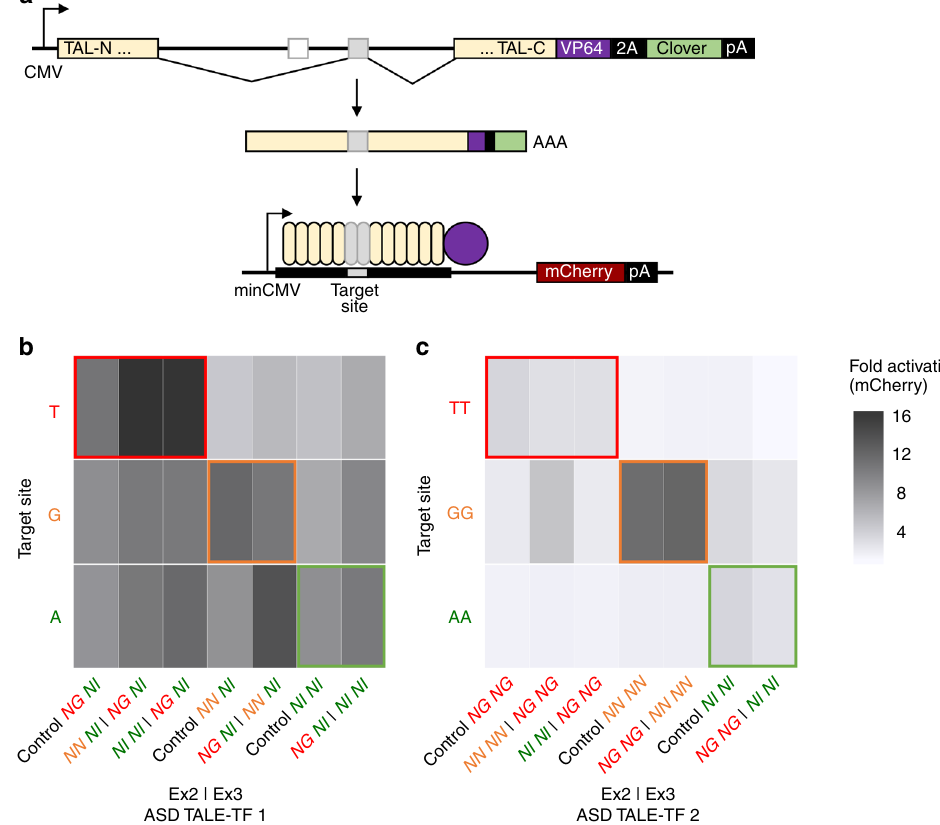
Fig. 5 Alternatively spliced transcription factors control gene activation from cognate reporters. a Schematic representation of the fl uorescence reporter system for testing promoter sequence recognition of ASD TALE-TF devices generated by MEAS. A self-cleavage peptide (2A) and Clover tag are included in exon 4 of the ASDs. ASD TALE-TF devices built using the base intron framework splice to isoform 1-3-4 by default to activate mCherry fl uorescence. b ASD TALE-TF 1 devices and c ASD TALE-TF 2 devices were co-transfected with reporters harboring cognate and non-cognate target sites in their binding sites. The fold activation was determined via fl ow cytometry analysis of mCherry fl uorescence in transfected HEK-293T cells, and calculated as the ratio of the median mCherry fl uorescence intensity of cells co-transfected with and without the speci fi ed ASD TALE-TF. Fold activations from biological triplicates were averaged and reported within an error range of ±1 standard deviation. Colored rectangles (red, orange, and green) indicate activation from cognate reporters. Source data are provided as a Source Data fi